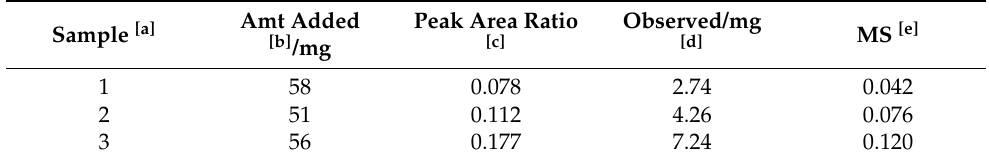
Table 2. Determination of butoxy groups in hydroxybutyl starch